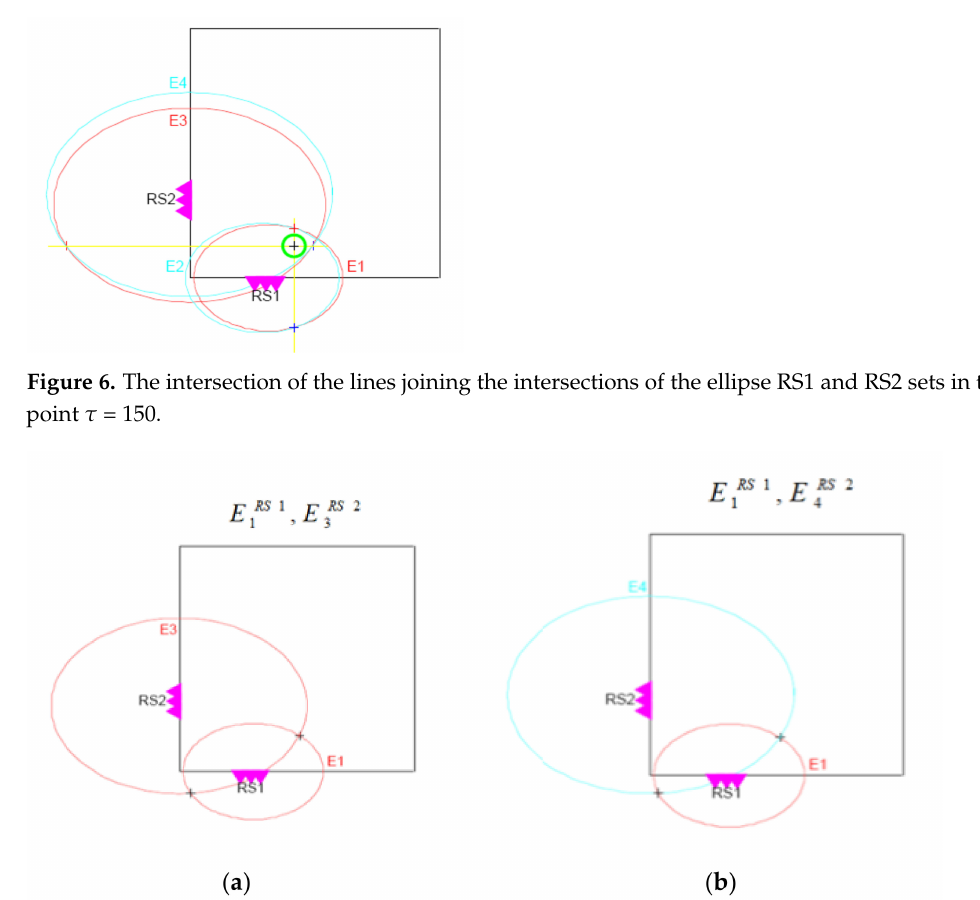
Figure 7. Combined intersections of ellipses: ( a ) E1 sets RS1 and E3 sets RS2 and ( b ) E1 sets RS1 and E4 sets RS2.